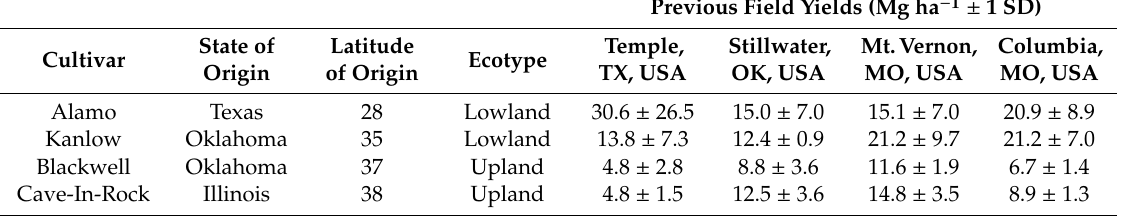
Table 2. Switchgrass cultivars data from Kiniry et al. (2013). Previous field yields are from the third growing